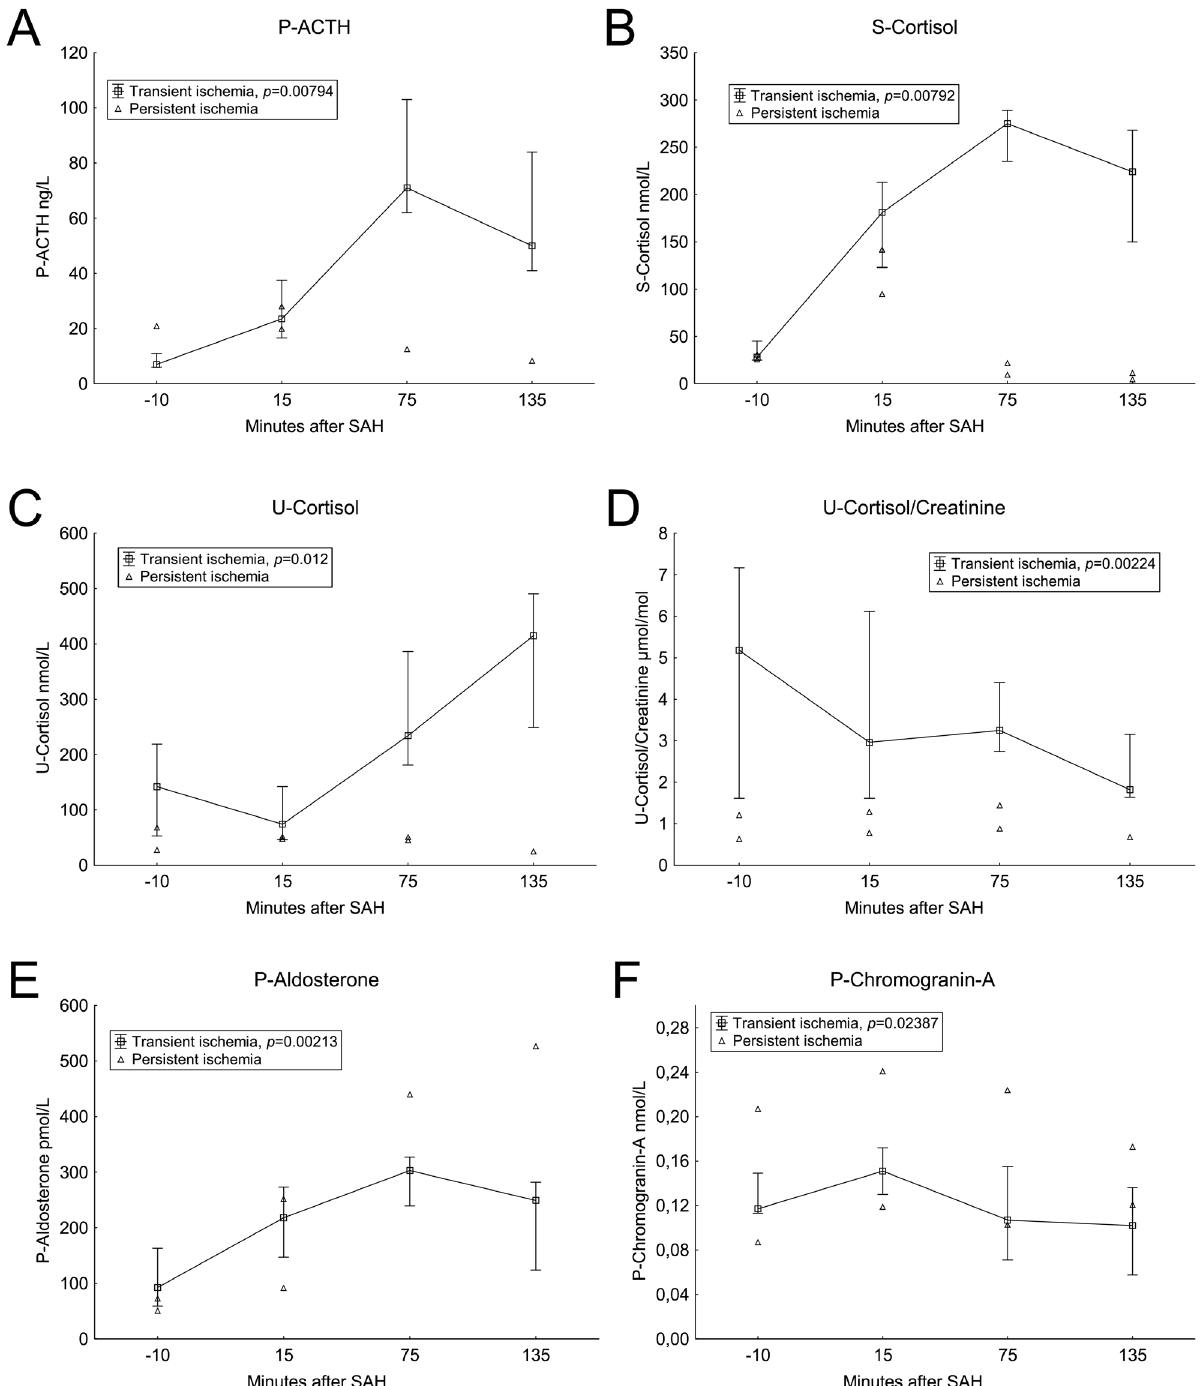
Fig 1. Blood hormones. Median values with 25 th and 75 th percentiles. Animals with persistent ischemia are displayed separately. Significance testing of change over time with the Friedman test. Time scale is non-linear.